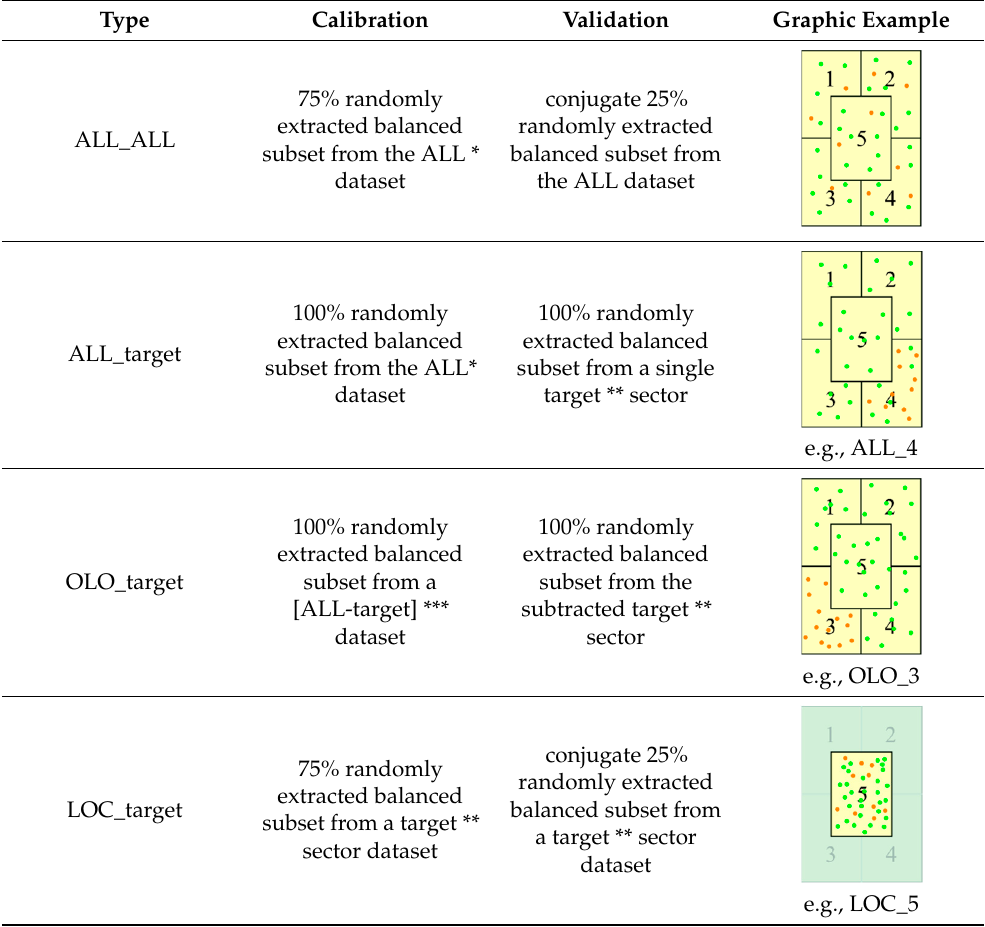
Table 2. Adopted model building scheme for the tested models. Green and orange dots represent calibration and validation cases, respectively, on the schematized five sectors.